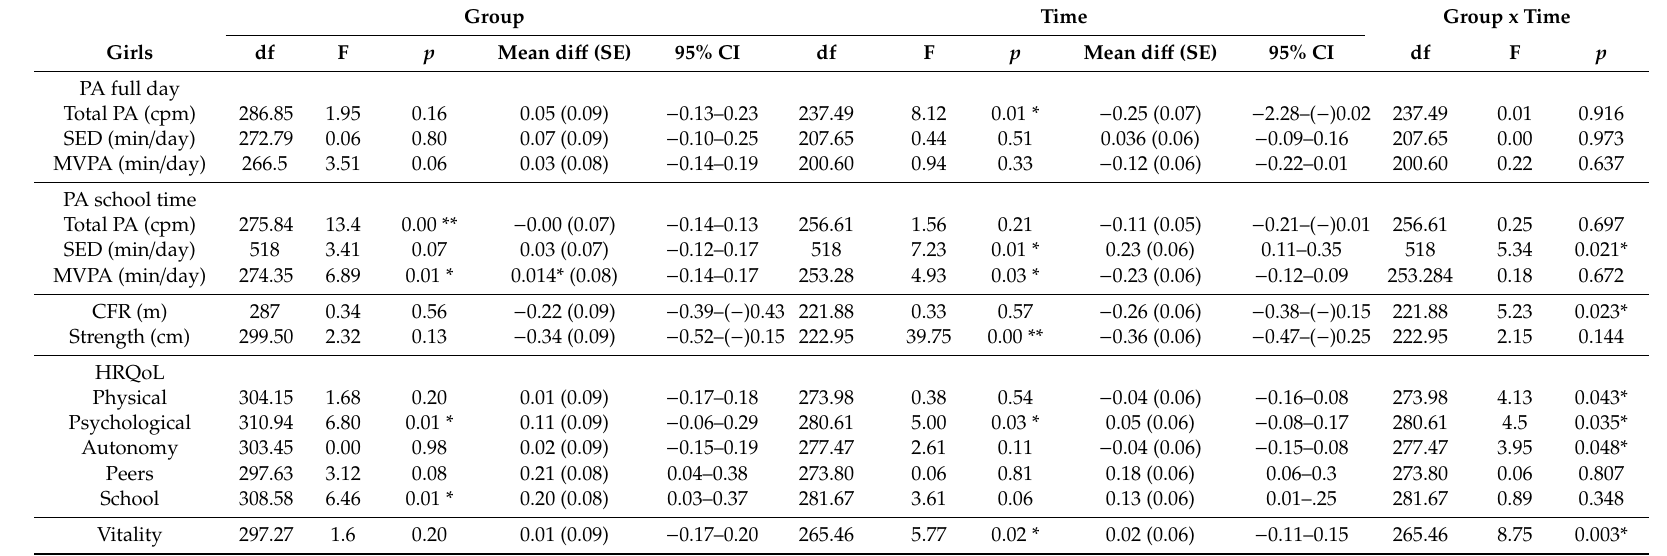
Table 6. E ff ects for